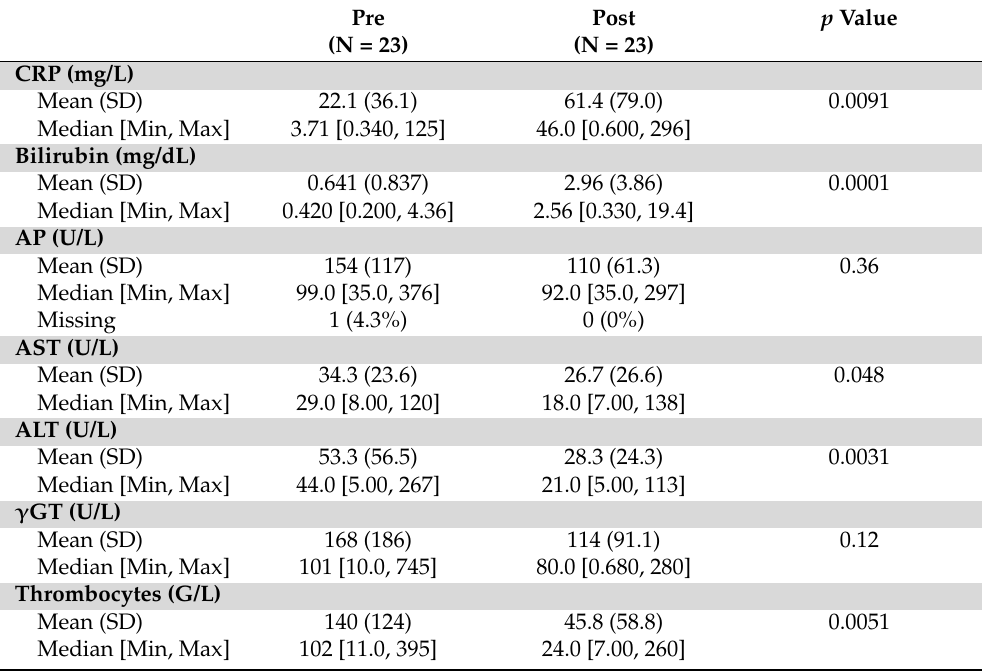
Table 2. Laboratory Parameters.